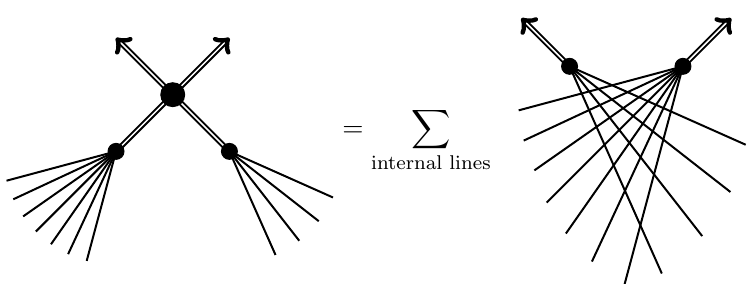
Figure 6 . A pictoral representation of the the bootstrap/fusion equations for the case a 1 = 7 and a 2 = 4. In general one has the sum over all the possible quantum numbers of the internal lines on the right-hand side. Our focus is on scalar processes for which the quantum numbers are (cid:12)xed and no sum is